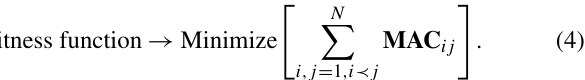
vector indicates that one sensor is located on the DOF of